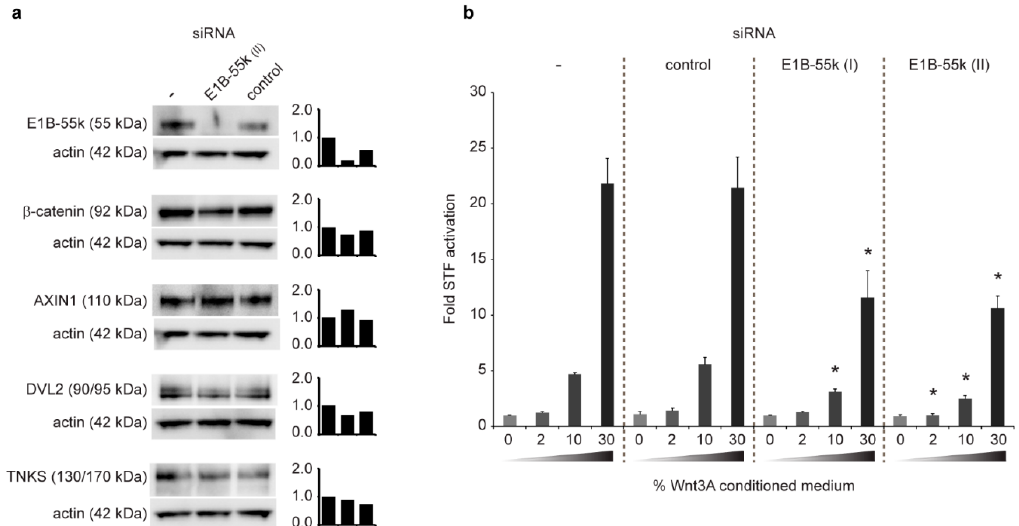
Figure 4. Reduction of E1B-55k protein levels in HEK293 cells causes decreased WNT/ β -catenin mediated transcriptional activation upon Wnt3A agonist treatment. ( a ) Western blot analysis of E1B-55k, TNKS, AXIN1 and DVL2 protein levels in untreated (-) and HEK293 cells treated with E1B-55k and control siRNA as indicated. Actin protein levels as loading control are shown below the corresponding bands. The bars shows the quantification of protein levels as determined by calculating the ratio of intensities of the respective protein bands relative to the corresponding actins band. Protein levels relative to untreated cells which where normalized to 1.0 are shown. ( b ) STF reporter gene assay measuring β -catenin mediated transcriptional activation in HEK293-STF/Ren cells treated with none (-), control or two independent E1B-55k siRNA constructs (I and II). The cells were incubated in growth medium supplemented with 0%, 2%, 10% or 30 % Wnt3A CM as indicated. Shown is fold STF activation relative to untreated cells (without siRNA and Wnt3A CM) from three parallel measurements. Error bars represent SD. Asterisk indicate significant difference (one-way ANOVA) relative to corresponding control siRNA-treated cells. For treatment with 2% Wnt3A CM: E1B-55k siRNA (II) p = 0.0170; for treatment with 10% Wnt3A CM: E1B-55k siRNA (I) p < 0.0001, E1B-55k siRNA (II) p < 0.0001; for treatment with 30% Wnt3A CM; E1B-55k siRNA (I) p = 0.0003, E1B-55k siRNA (II) p = 0.0001.